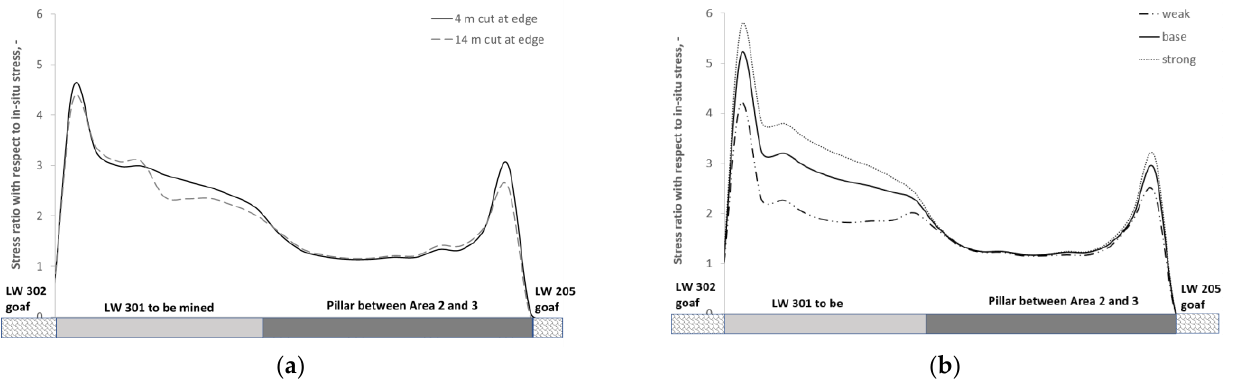
Figure 13. Vertical stress development ahead of longwall 301 under ( a ) two different cut heights and ( b ) three different strengths of overburden.